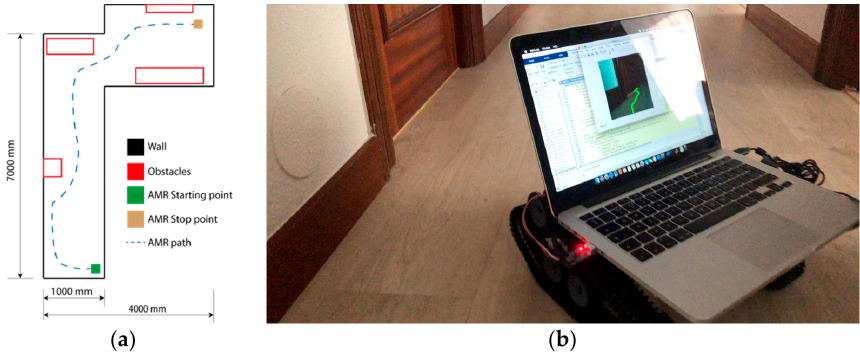
Figure 14. The obstacle avoidance in 4.45 s: ( a ) The representation at the sketch, ( b ) The obstacle avoidance real situation.